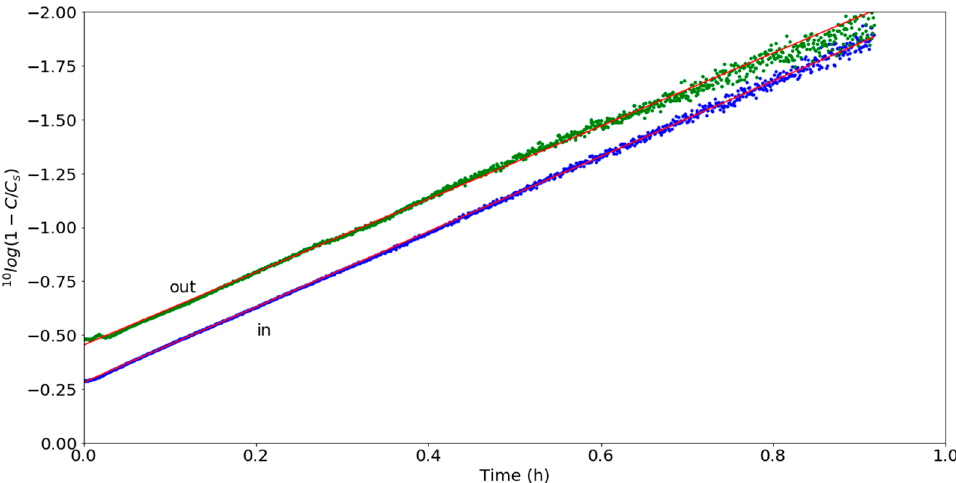
Figure 8. DO (dissolved oxygen) content before (blue) and after (green) the vortex showerhead expressed as the logarithm of 1 − C/C s , where C is the concentration in ppm, and C s is the saturation concentration determined from fitting the data to formula 3. The fits are shown in red. In this notation, 0 represents zero DO, and − 2 represents a DO value of 0.99 ꞏ C s .